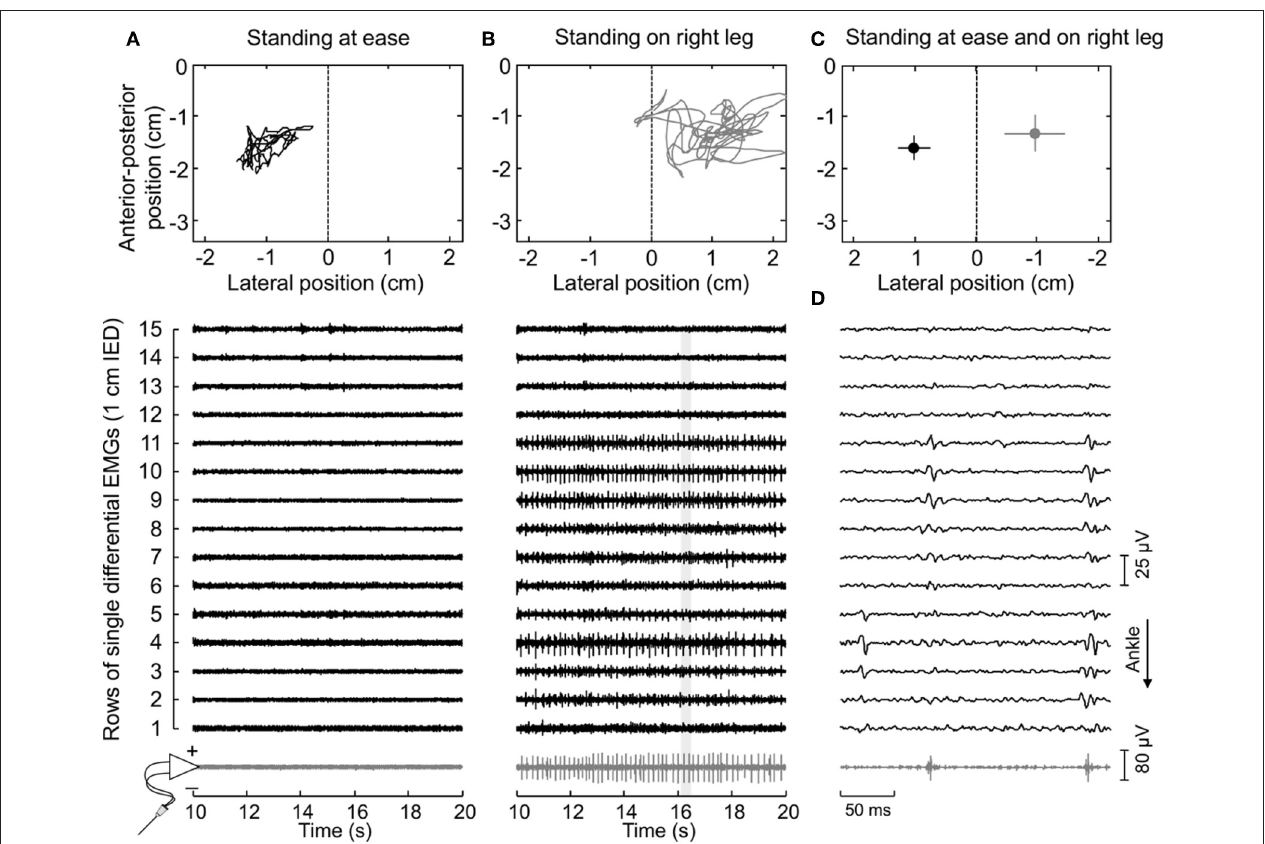
FIGURE 2 | Muscle activity and standing posture. (A) illustrates the CoP position along the lateral and anterior-posterior axes (top panel) and the surface (black traces) and intramuscular (gray traces) electromyograms (EMGs) detected during 10s for a representative subject. EMGs are shown exclusively for the paretic (right) MG. The dashed line in the top panel denotes the CoP location where body weight distributes roughly symmetrically between limbs ( Figure 1A ). Note that action potentials are not present both in the surface and intramuscular recordings. When this subject shifted his CoP toward the paretic limb (B) , action potentials could be clearly appreciated. An expanded view of EMGs (light gray rectangle) is shown in (D) . Note there is a correspondence in the instants when action potentials were detected by the intramuscular electrodes and by the central though not by the distal nor proximal electrodes in the surface array. (C) shows the mean CoP position, calculated over the entire recording (60s), while the subject stood at ease (black circle) and on his right leg (gray circle). Horizontal and vertical traces correspond to the standard deviation along the lateral and sagittal directions,